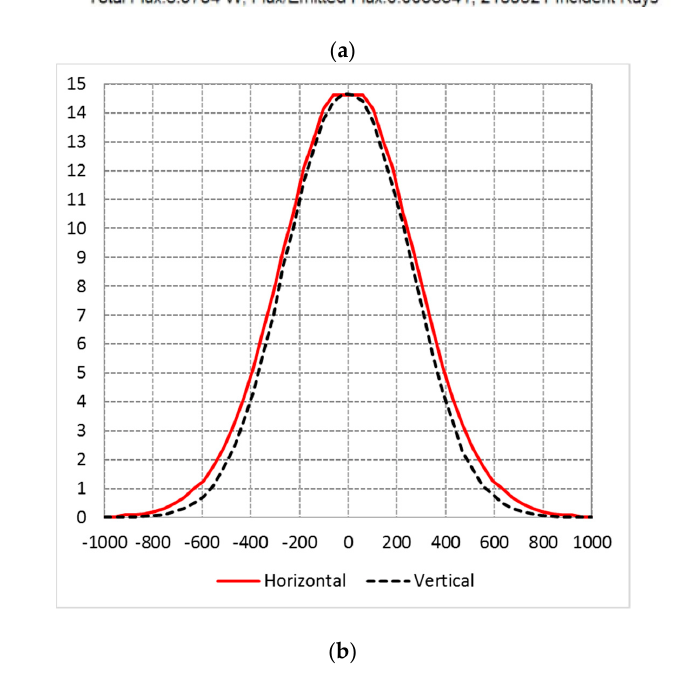
Figure 14. Simulated target irradiance for a 5 × 5 heliostat field with row distance 4 m and column distance 10 m, irradiance map ( a ); corresponding central profiles ( b ).